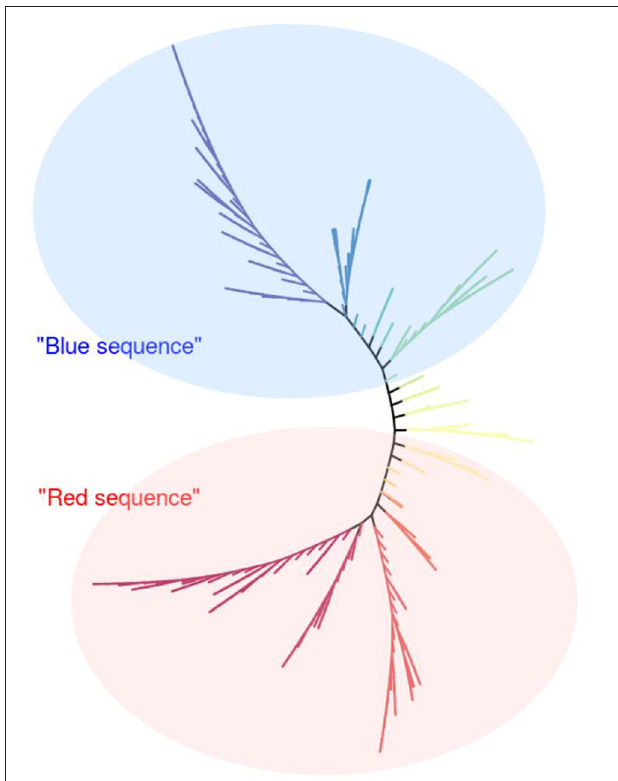
FIGURE 3 | The cladistics tree of 300 pre-clusters of the WINGS sample of 1,494 galaxies. The tree representation is unrooted, but the lower masses are at the top. The colors of the branches correspond to the groups and are the same as in Figure 4